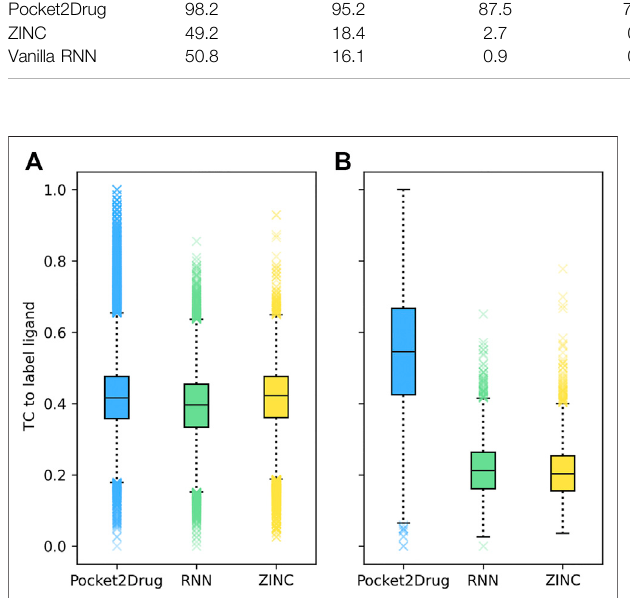
FIGURE 4 | Chemical similarity of molecules generated by Pocket2Drug to label ligands. Label ligands are molecules bound to target pockets in experimental complex structures, (A) AMP-PNP binding to MSK1 and (B) ß - D -allose binding to ALBP. Chemical similarity is measured with the Tanimoto coef fi cient (TC).